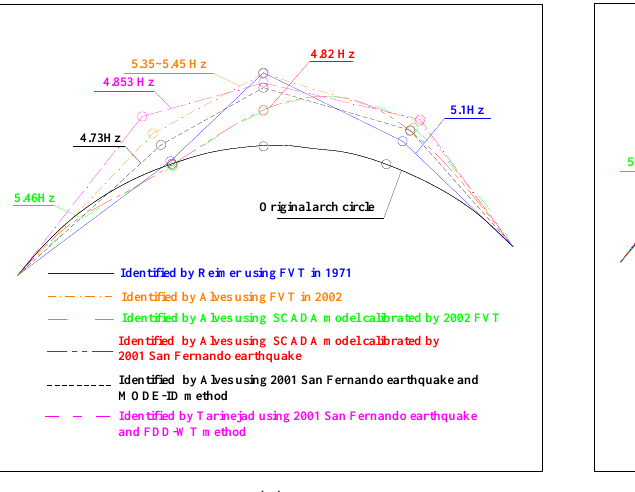
Table 8. Comparison between the identified first-order symmetric vibration modes based on San Fernando seismic monitoring in 2001 and the analysis results of FVT and FEM.